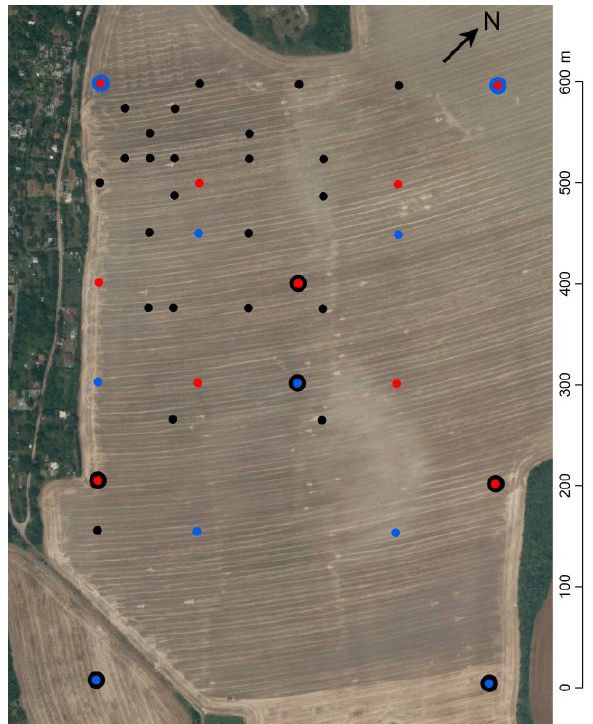
Figure 1. Testing field together with 42 marked points